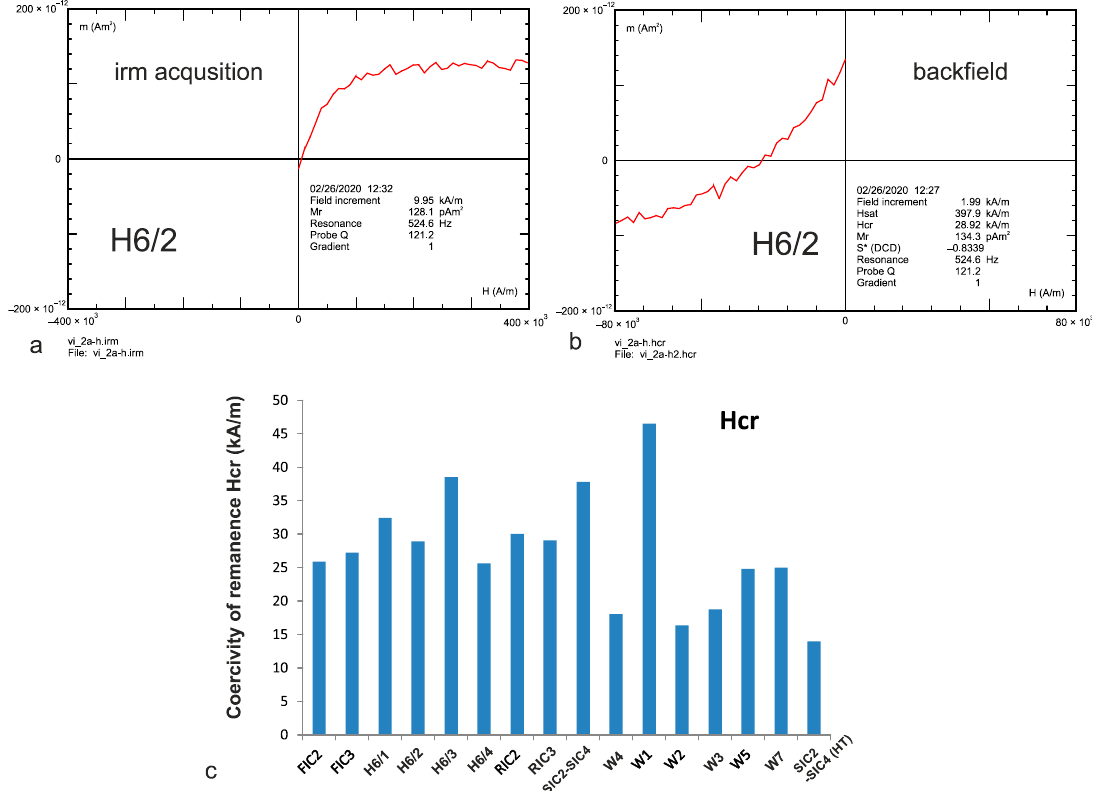
Figure 14. Remanence curves for dust residues: ( a ) example of IRM acquisition curve (H6/2 sample)— fast saturation with a low H, specific for a low-coercivity phase; ( b ) example of a backfield curve, Hcr value is determined (H6/2 sample); ( c ) distribution of Hcr values (heated SIC2-SIC4 sample shown on the far right—see also Table A3, Appendix B).